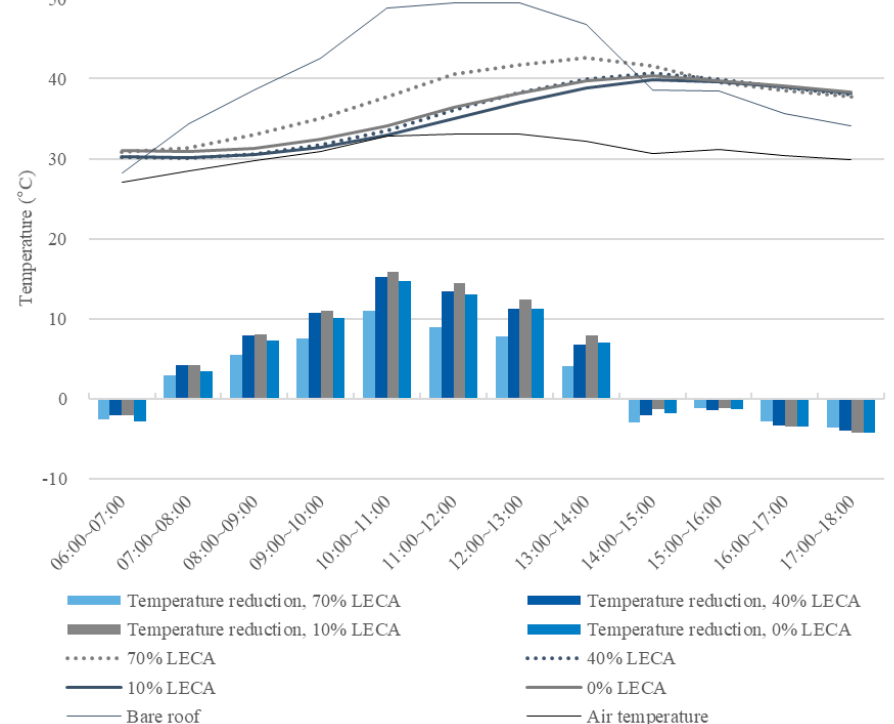
Figure 10. Temperatures and temperature reductions in the cases of the roofs with 0%, 10%, 40%, and 70% LECA laid at the bottom without plants (25 July 2017 06:00:09 to 25 July 2017 17:50:09).